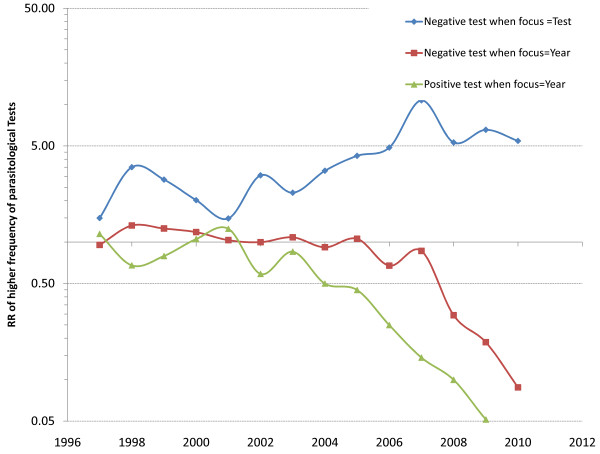
Relative Risk (RR) of a positive or negative parasitological test by using the positive test as reference (blue line) or the year 1996 (red and green lines for negative and positive tests respectively) in the negative binomial model of counts of parasitological tests.